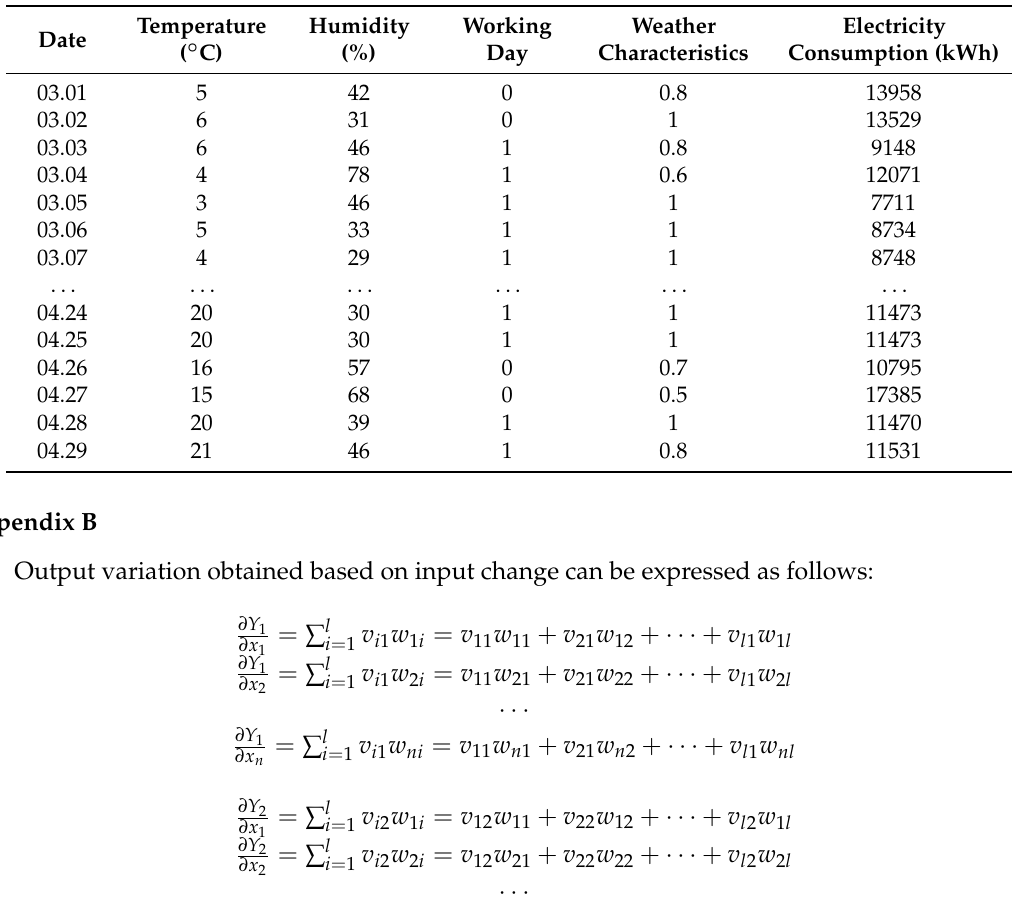
Table A1. Shopping mall historical data